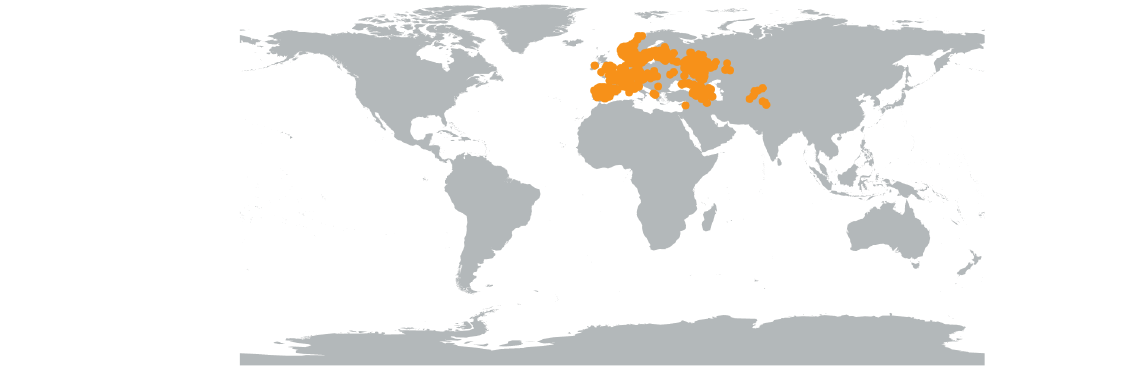
Fig. 21. Distribution of Malus sylvestris (L.)